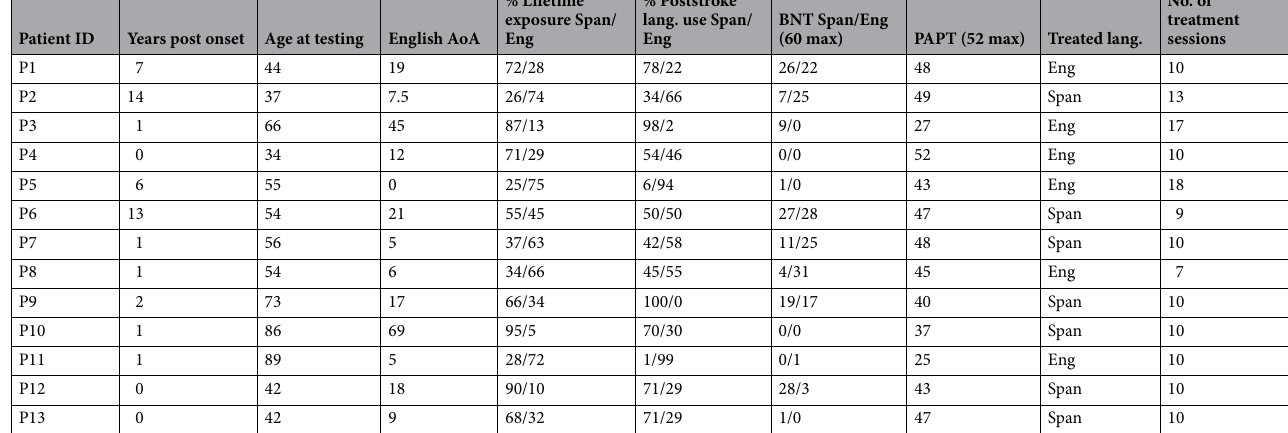
Table 1. Demographics, bilingual background, language scores and treatment information that served as input for simulations of language impairment and treatment outcomes. AoA age of acquisition, Span Spanish, Eng English, Lang Language, BNT Boston naming test, PAPT Pyramid and Palm Trees